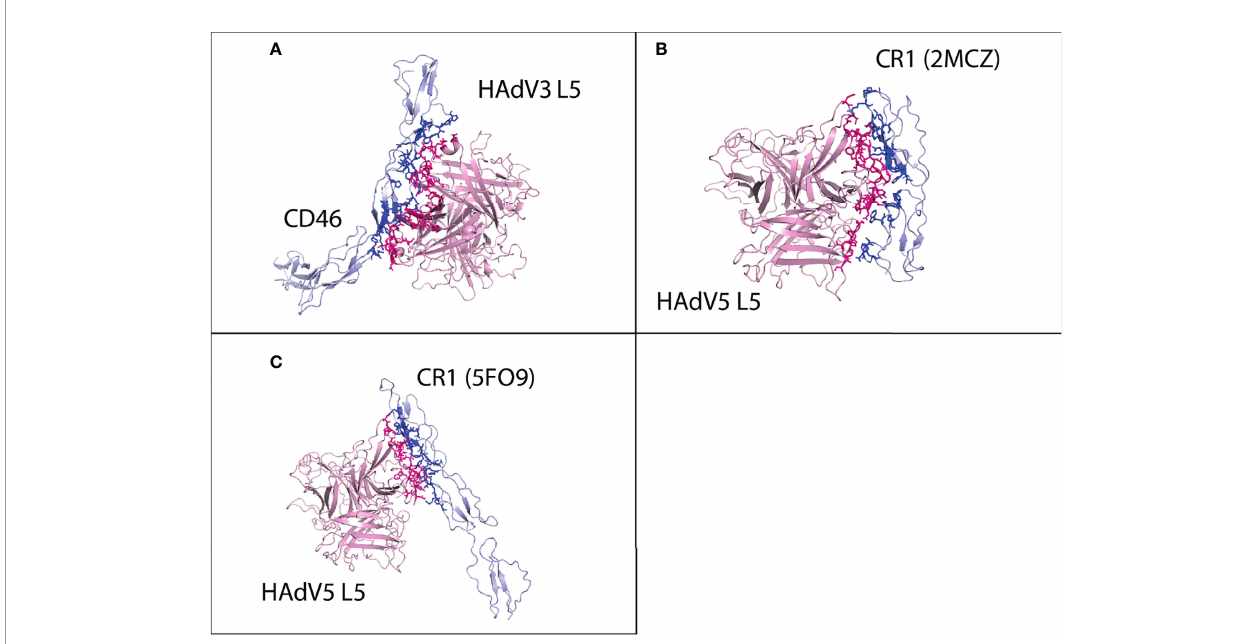
FIGURE 5 | Protein – protein HAdV3 and HAdV5 L5 protein with human CD46 and CR1 receptors. (A) CD46 made a total of 105 interactions with HAdV3 L5 protein. (B) CR1 domains 1 and 2 made 87 interactions with HAdV5 L5 protein. (C) CR1 domains 15, 16, and 17 made 94 interactions with HAdV5 L5